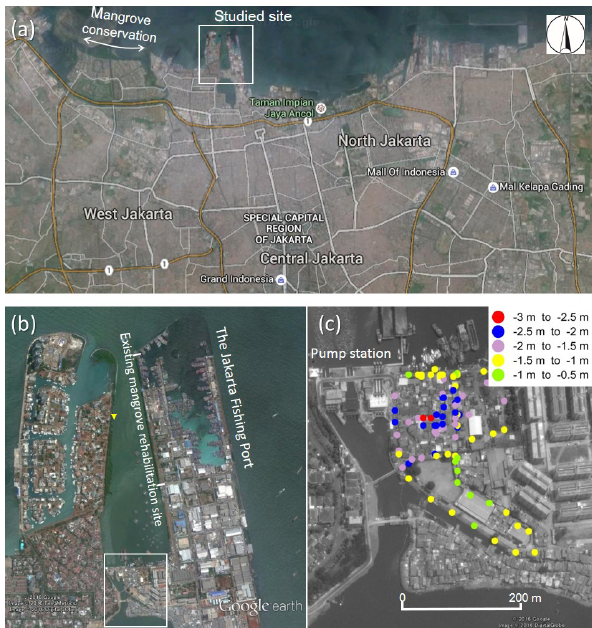
Figure 3. (a) Map of central and northern Jakarta, (b) Study area, which is adjacent to Jakarta’s largest fishing port. A yellow inverse triangle indicates the location of the installed pressure sensor, and (c) the district of Pluit, in which the authors measured ground eleva- tions with a laser rangefinder (Fig. 2b). The ground elevations were adjusted to the highest water level shown in Fig. 4.